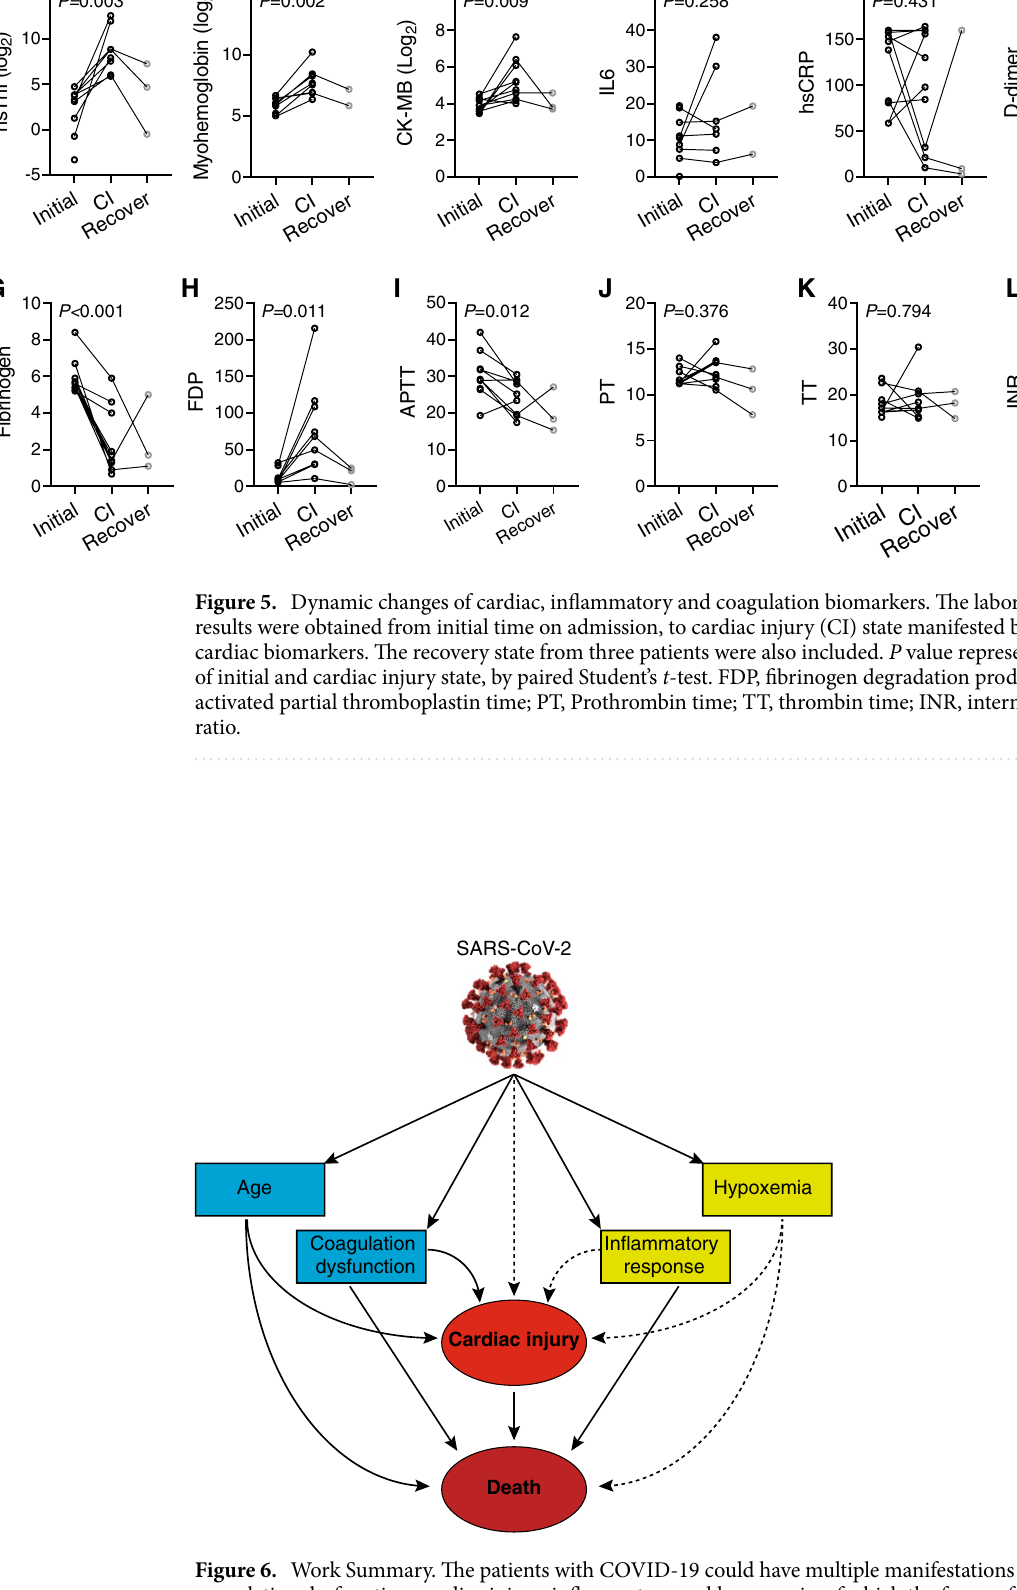
Figure 6. Work Summary. The patients with COVID-19 could have multiple manifestations like elder age, coagulation dysfunction, cardiac injury, inflammatory and hypoxemia, of which the former four factors are associated with in-hospital mortality. In the meantime, cardiac injury is associated with senior age and coagulation, but not directly associated with inflammatory response and